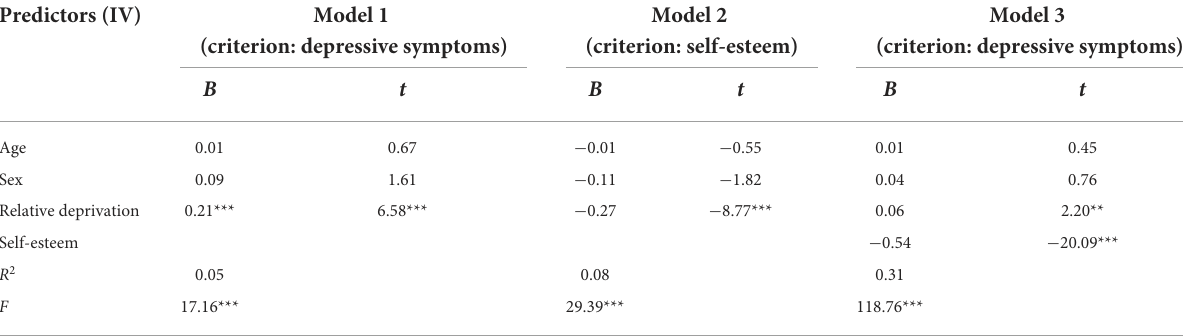
TABLE 3 Mediating effect of self-esteem between relative deprivation and depressive symptoms.